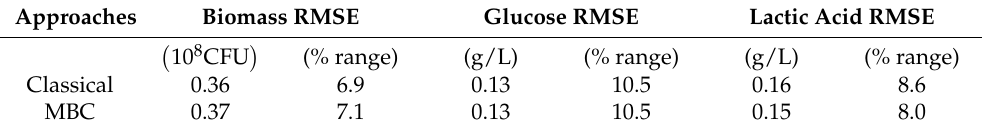
Table 4. Validation of the predicted biomass, glucose, and lactic acid concentrations with respect to the actual offline measurements. The prediction was performed by the chemometric model (partial least square regression) trained with the simulated concentrations of biomass, glucose, and lactic acid.